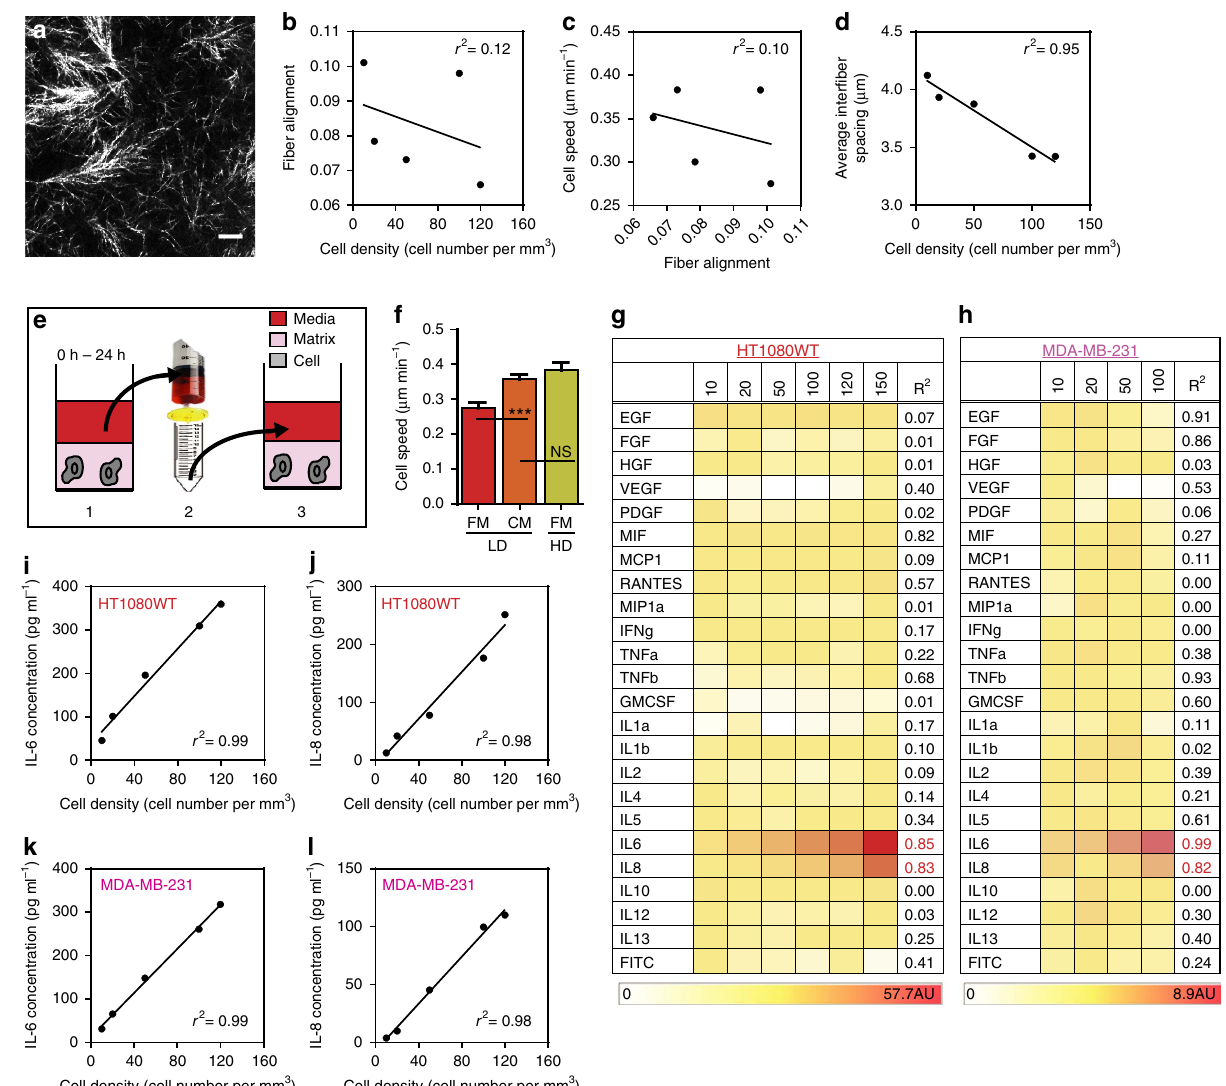
Figure 2 | Biochemical cues. ( a ) Reflection confocal micrograph. Singular of 3D collagen matrices. Scale bar, 10 m m. ( b ) Correlation plot of fibre alignment versus cell density. ( c ) Correlation plot of cell speed versus fibre alignment. ( d ) Correlation plot of average inter-fibre spacing versus cell density. ( e ) Method to prepare condition medium: medium is incubated for 24 h with a collagen matrix containing a high density of cells, 50cellsmm (cid:2) 3 (HD), which is then filtered using a 0.45- m m filter, and added to a matrix containing a low density of cells, 10cellsmm (cid:2) 3 (LD). ( f ) The addition of conditioned medium (CM) from a matrix containing a high cell density (HD) increases the speed of cells in a matrix containing a low cell density (LD). The HD cell speed in the presence of fresh medium (FM) is recapitulated in LD when using CM. ( g ) Secretomic analysis of CM harvested from human fibrosarcoma cells indicates that levels of interleukin 6 (IL-6) and interleukin 8 (IL-8) increase as a function of HT1080 cell density in the matrix, while levels of other major cytokines do not significantly change. ( h ) Secretomic analysis of conditioned medium from human breast carcinoma cells (MDA-MB-231) confirms our observations with HT1080 cells. ( i , j ) Increasing density of human fibrosarcoma cells in the matrix increases the concentrations of secreted IL-6 (A) and IL-8 (B), as analysed by ELISA. ( k , l ) Increasing cell density of human carcinoma cells in the matrix increases the concentrations of secreted IL-6 (A) and IL-8 (B), as analysed by ELISA. In all panels, data is represented as mean ± s.e.m. from three independent experiments. * P o 0.05; ** P o 0.01; *** P o 0.001